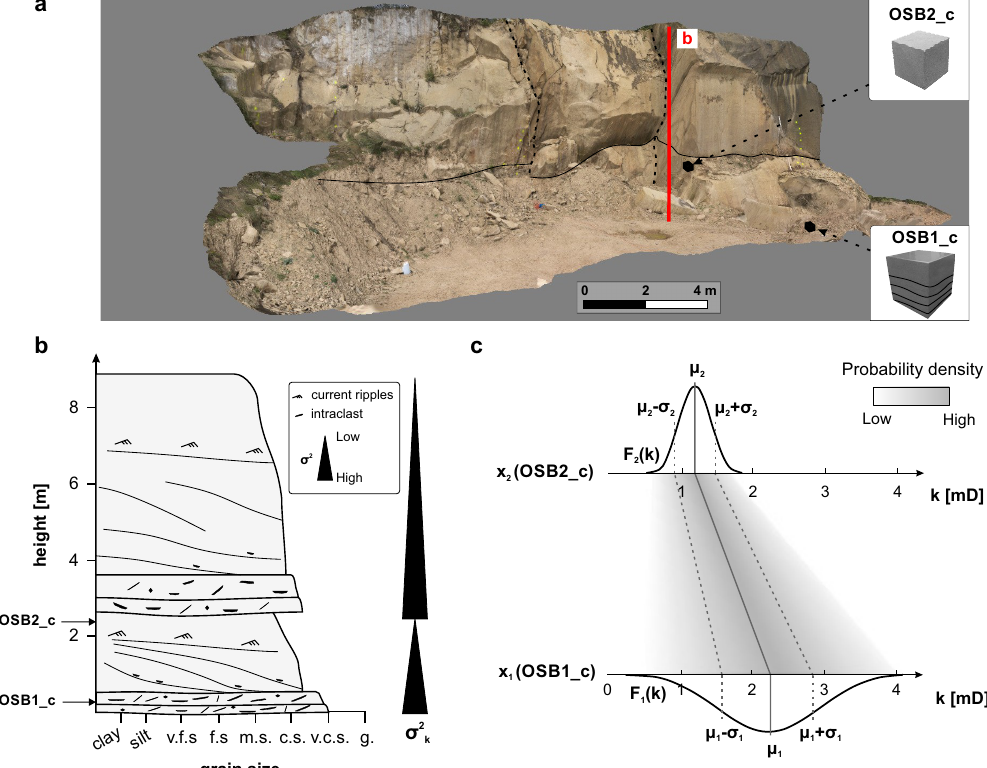
Figure 3. ( a ) Photogrammetric model of the investigated sandstone quarry. The outcrop is compartmentalized by two scissor faults and consists of two lacustrine-deltaic Bouma sequences [40]. ( b ) Sedimentological 1-D section of the sedimentary architecture observed in the outcrop. The Bouma sequence provides an erosive base. One sequence is characterized by a fining-upward trend and consists of intraclasts-rich massive sandstones at the base and trough cross-bedded and ripple cross-bedded sandstones towards top [40]. ( c ) Spatial interpolation of a PDF exemplary illustrated with both theoretical Gaussian distributions derived from the measurements of OSB1_c and